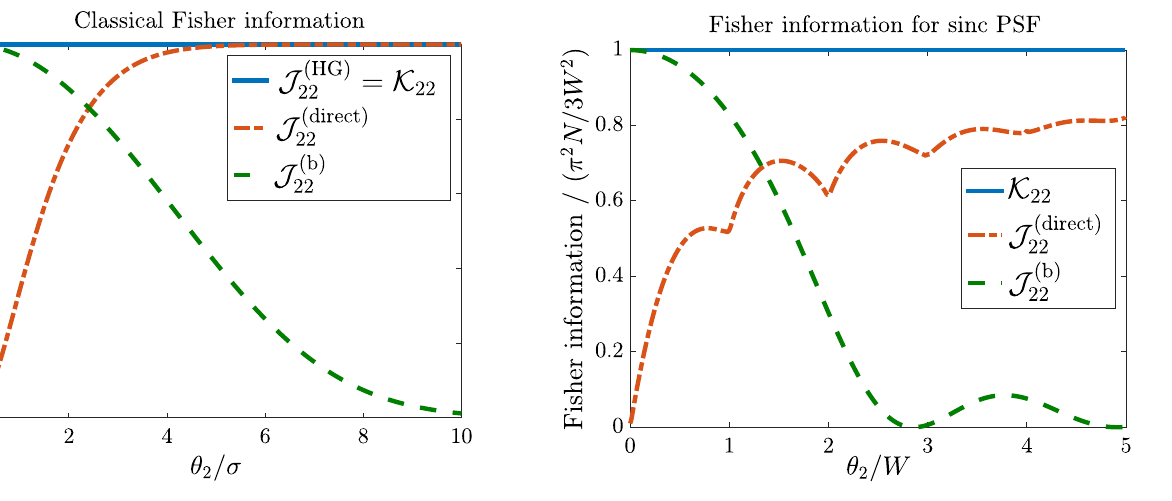
FIG. 8. Fisher information for separation estimation versus normalized separation θ 2 = σ for a Gaussian point-spread function. J ð HG Þ 22 is the information for the ideal Hermite-Gaussian-basis measurement, which is equal to the quantum value K 22 , J ð direct Þ 22 is for direct imaging, and J ð b Þ 22 is for binary SPADE. The vertical axis is normalized with respect to J ð HG Þ 22 ¼ K 22 ¼ N= ð 4 σ 2 Þ .